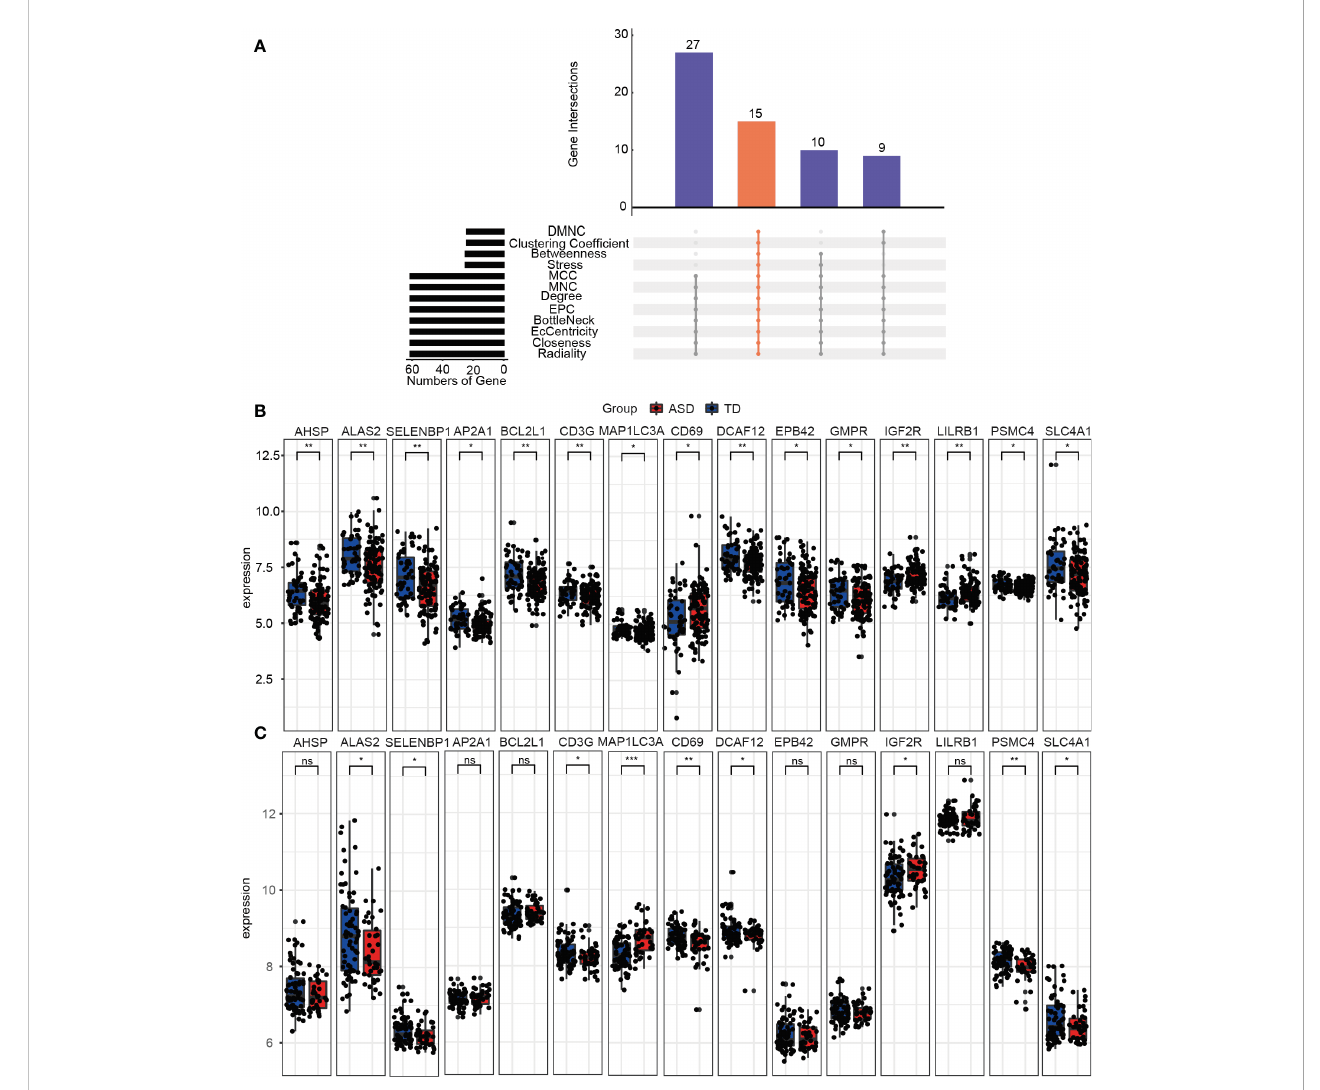
FIGURE 6 Identifying the hub genes. (A) The 12 algorithms used to screen for hub genes in the R package “ UpSet ” . Expression levels of 15 hub genes in the (B) training and (C) validation groups. ns, not signi fi cant; * p < 0.05; ** p < 0.01; *** p <